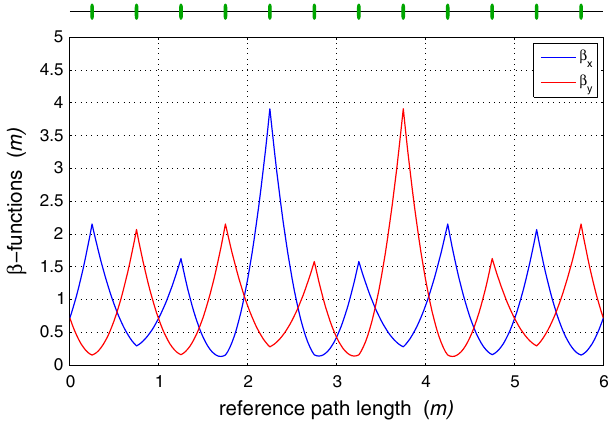
FIG. 6. Betatron functions along the phase advance scan beam ¼ 60 (cid:8) , (cid:8) ¼ (cid:4) 40 (cid:8) line for (cid:8) x y